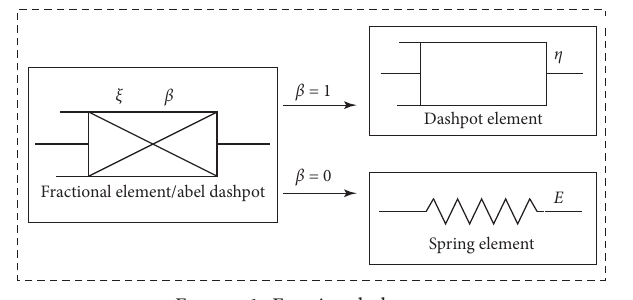
Figure 1: Fractional element.